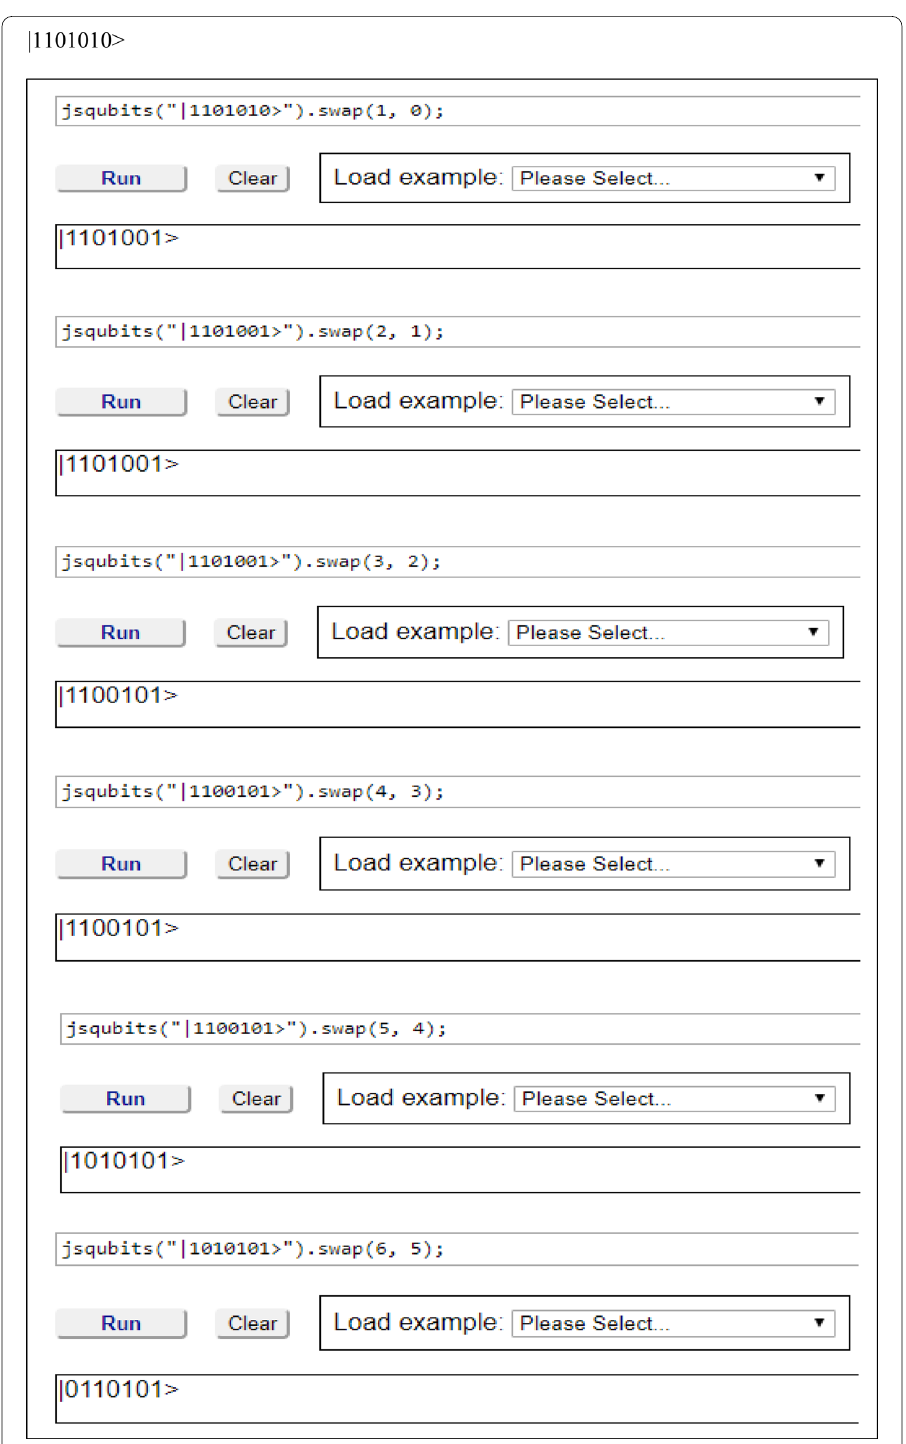
Fig. 24 Rotating quantum bit string |1101010 > by using a swap